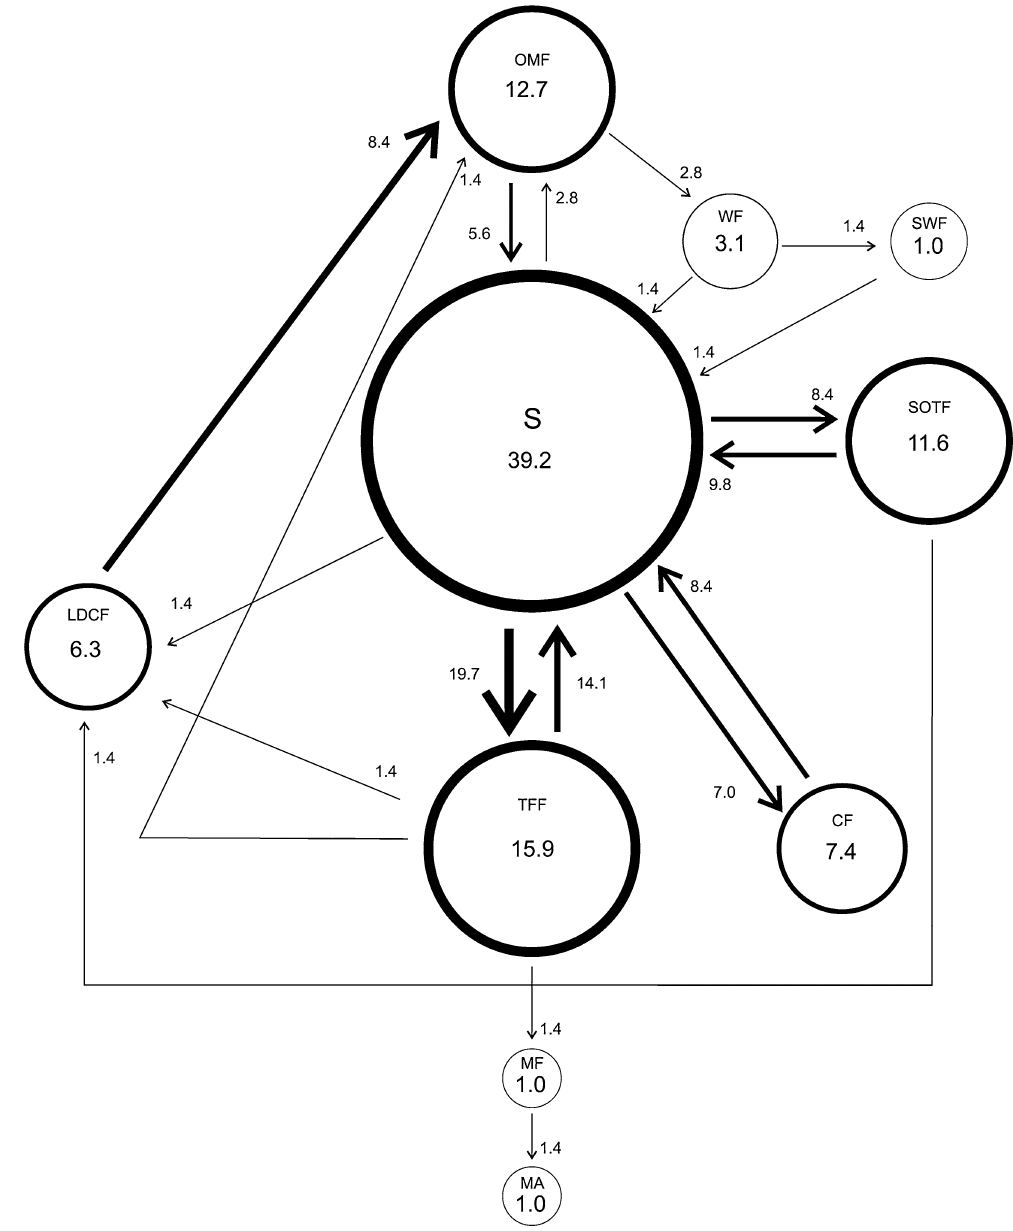
Figure 4. Courtship behavior of Anastrepha curvicauda subordinate 7–8 days old males caged with a 5–7 days old virgin female. Circles represent behavioral elements and arrows transitions. Circle size and line thickness are proportional to their percentage values. Dotted lines represent transitions with a median < 1. See Table 1 for